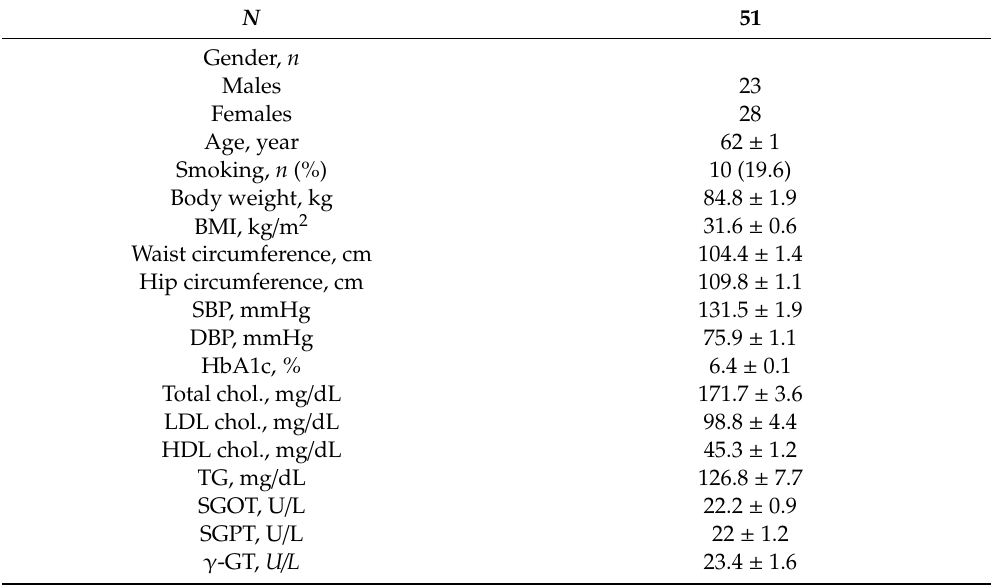
Table 1. Baseline characteristics of the study